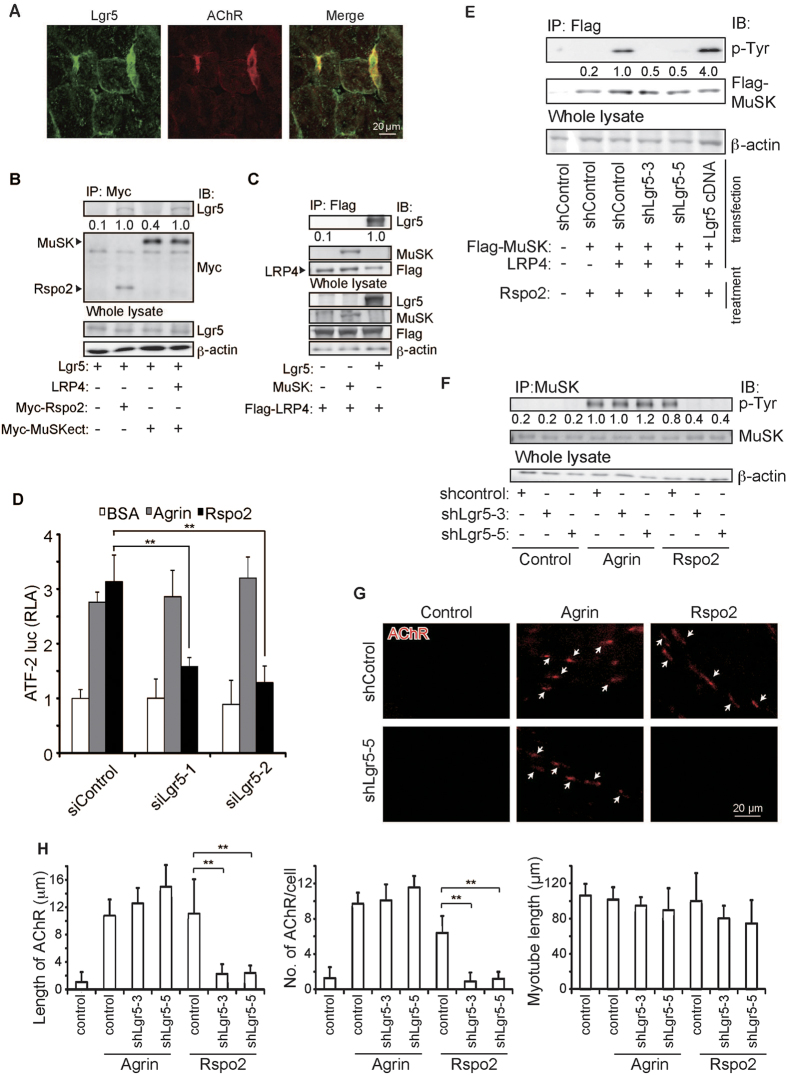
The Rspo2/Lgr5 complex induces activation and phosphorylation of MuSK and AChR clustering.(A) Lgr5 immunostaining and α-bungarotoxin staining of the NMJs as in Fig. 2B. (B,C) Lgr5 was co-immunoprecipitated with anti-myc (B) or anti-Flag (C) antibody in HEK293 cells. The normalized ratio of co-immunoprecipitated Lgr5 to total Lgr5 is shown in Supplementary Fig. S3A and S3B, and the mean value is indicated below the blot. (D) ATF2-luciferase reporter assays as in Fig. 2D in siRNA-transfected HEK293 cells. RLA are normalized to that of BSA with siControl. Mean and SD are indicated (**p < 0.01 by t-test, n = 3). Efficiency of siLgr5 and the rescue experiment is shown in Supplementary Figs S3B and S3C, respectively. (E) The effects of Lgr5 on MuSK phosphorylation in L cells treated with 0.1 nM Rspo2. Total Flag-MuSK was immunoprecipitated (IP), and immunoblotted (IB) with indicated antibodies. The ratio of phosphorylated and total Flag-MuSK was normalized to that of the control knockdown (shControl) in lane 3. Quantification is shown in Supplementary Fig. S3F, and the mean value is indicated below the blot. Efficiency of shLgr5 in L cells is indicated in Supplementary Fig. S3E. (F) C2C12 myoblasts were infected with lentivirus expressing shControl or shLgr5. After differentiation into myotubes, 0.1 nM of BSA (Control), agrin, or Rspo2 was added. Phosphorylated MuSK was immunoprecipitated (IP) and immunoblotted (IB) with indicated antibodies. The band intensities were normalized to that of cells treated with 0.1 nM agrin and shControl. Quantification of phosphorylated MuSK is shown in Supplementary Fig. S3H, and the mean value is indicted below the blot. Efficiency of shLgr5 in C2C12 myotubes is indicated in Supplementary Fig. S3G. (G,H) C2C12 myoblasts were infected with lentivirus expressing shControl or shLgr5. After differentiation into myotubes, 0.1 nM of BSA (Control), agrin, or Rspo2 was added. AChR cluster was visualized with α-bungarotoxin (red). (F) Arrows point to AChR clusters in representative images. (G) Blinded morphometric analysis. Mean and SD are indicated (**p < 0.01 by t-test, n = 3). Instead of purified recombinant Rspo2, we also used Rspo2-containing conditioned medium, and showed the results in Supplementary Fig. S2D.